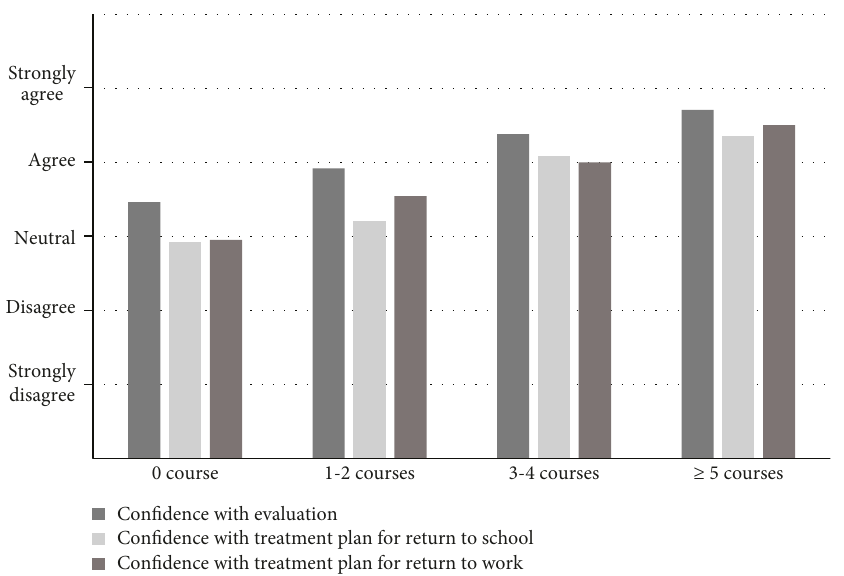
Figure 2: Perceived con fi dence and number of continuing education courses taken. Participants with and without clinical concussion experience reported their agreement with the following statements: “ I am con fi dent in evaluating a client with concussion, I am con fi dent in developing a treatment plan for return to learn, and I am con fi dent in developing a treatment plan for return to work. ” ∗ All values were statistically signi fi cant. P < 01 . χ 2 = 28 43 (I am con fi dent evaluating a client with concussion). χ 2 = 44 33 (I am con fi dent developing a treatment plan for return to school). χ 2 = 30 24 (I am con fi dent developing a treatment plan for return to